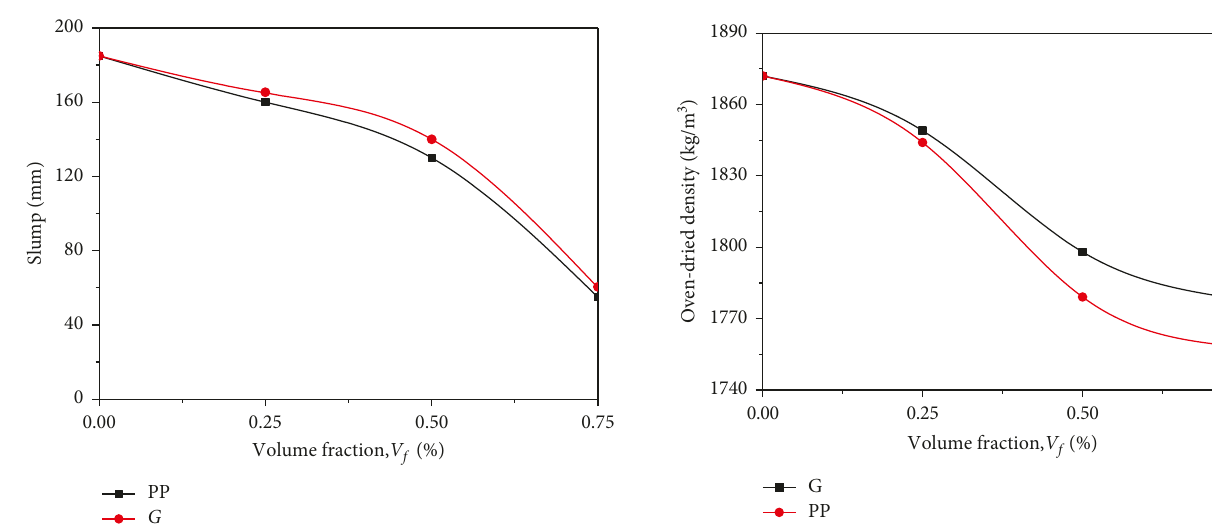
Figure 3: Relationship between the fibre content and slump value. Figure 4: Relationship between the fibre content and oven-dried density.